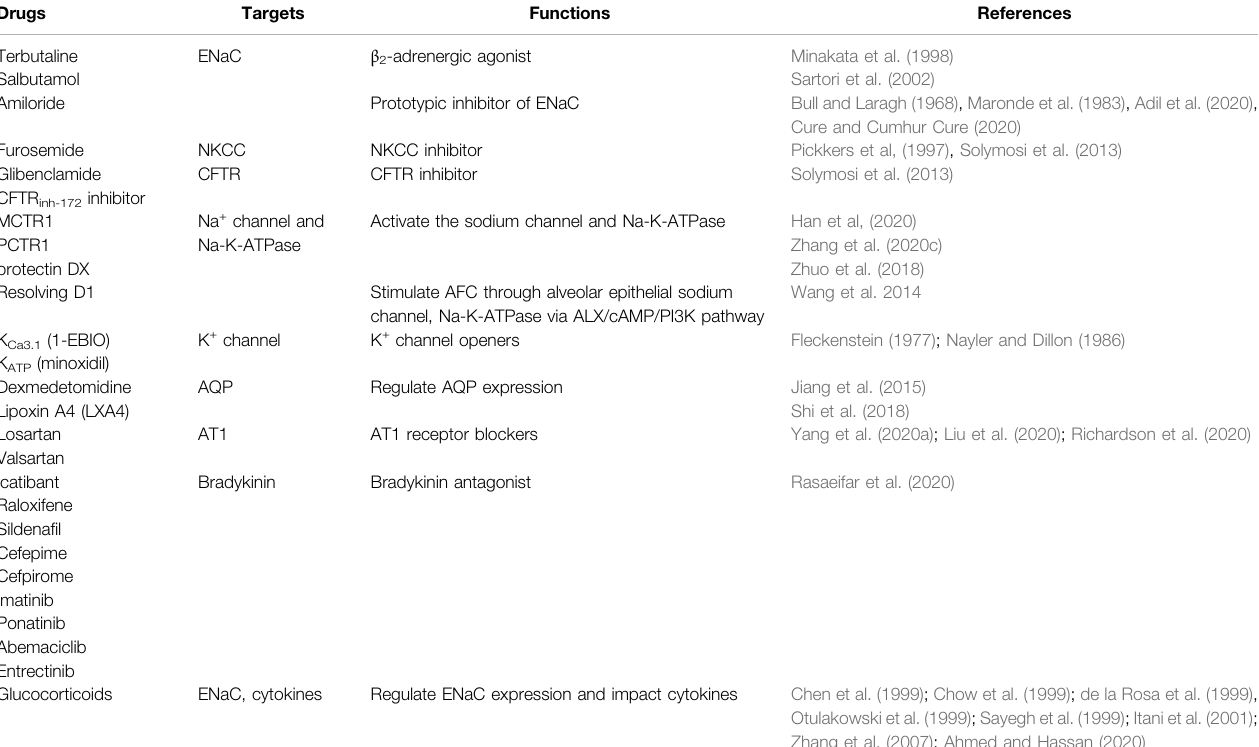
TABLE 1 | Potential drugs for normalizing humoral